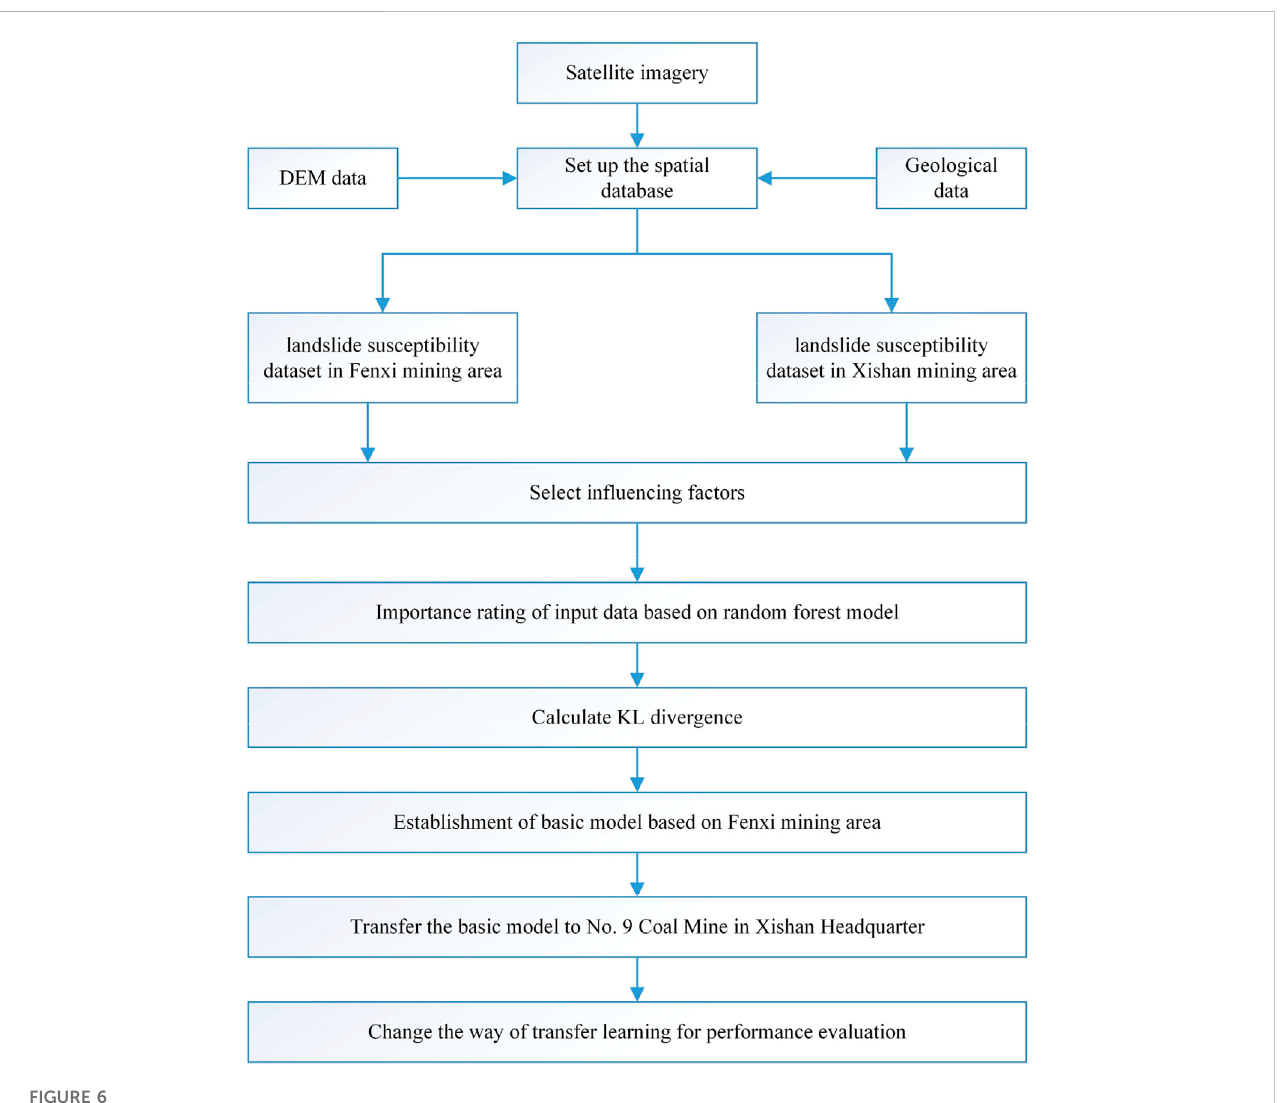
FIGURE 6 Entire fl ow